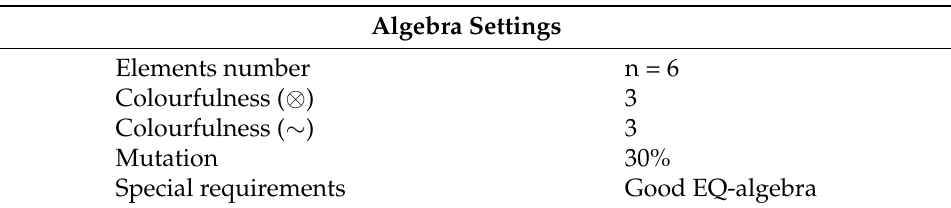
Table 5. EQCreator settings for good